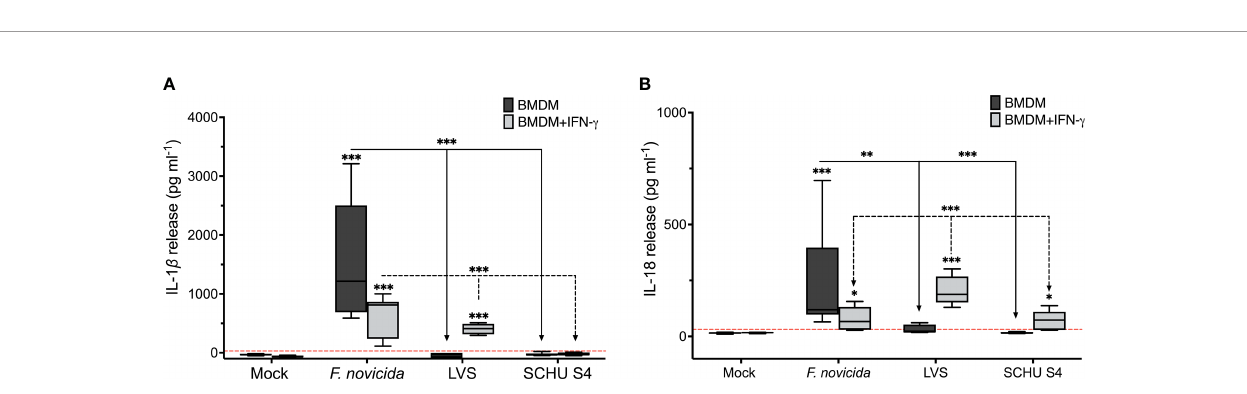
FIGURE 5 | Secretion of IL-1 b (A) and IL-18 (B) from BMDM in the presence or absence of IFN- g upon infection with indicated F tularensis strain using an MOI of 100 after 18 h of infection. Data represent median ± SEM from three independent experiments. ** P < 0.01, *** P < 0.001. The red dotted line indicates the limit of